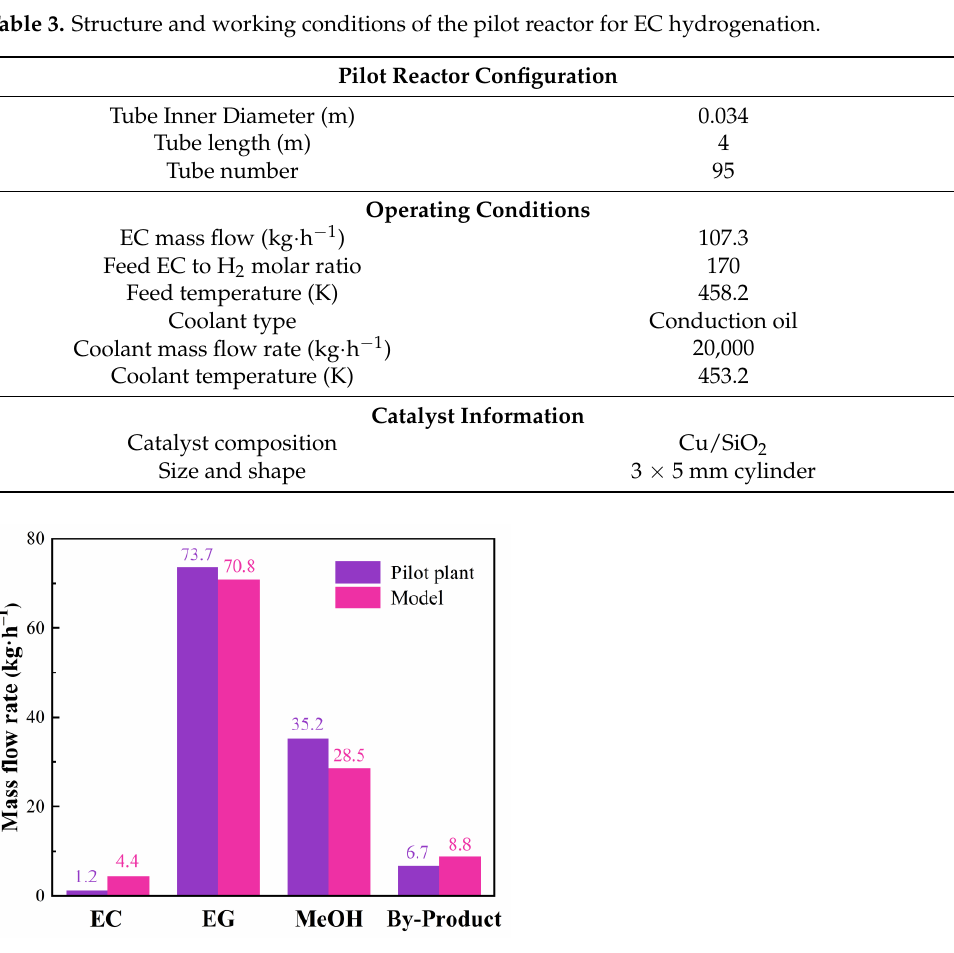
Figure 3. Comparison between pilot plant and simulation data for EC hydrogenation in the conduc- tion oil-cooled multi-tubular reactor.